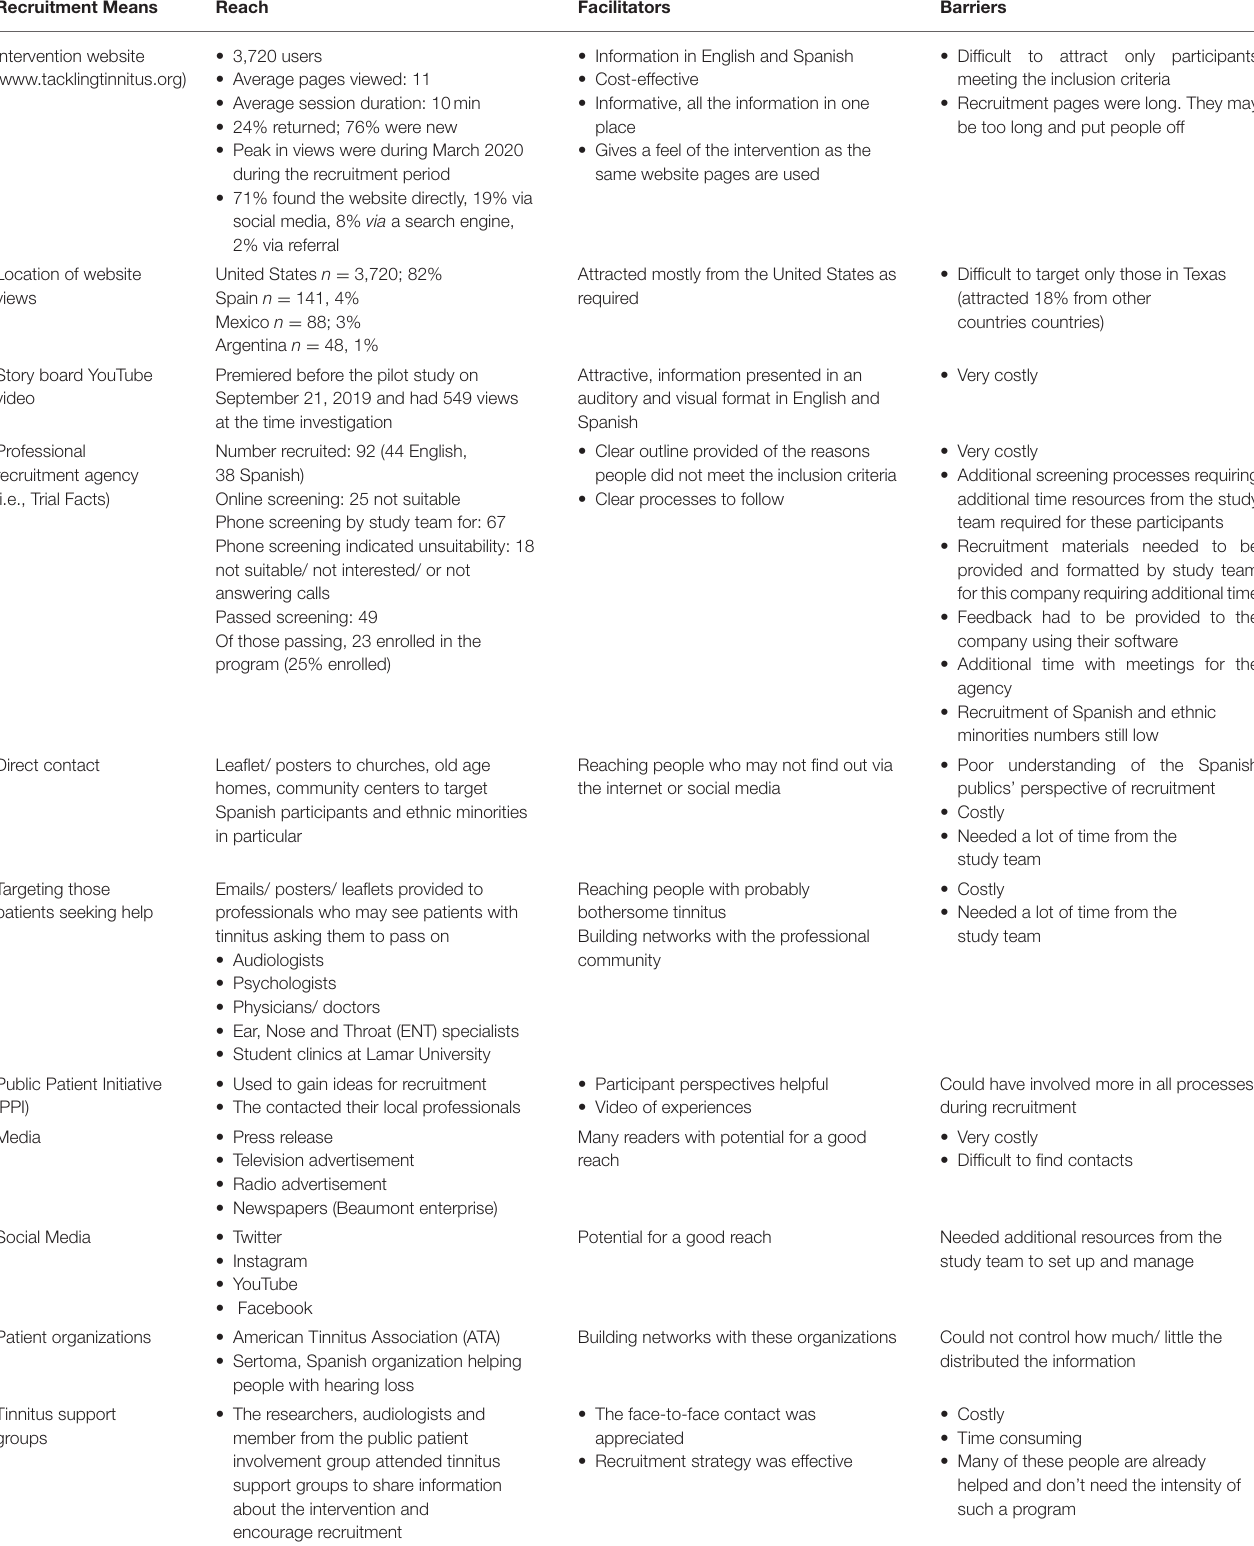
TABLE 2 | The various recruitment strategies used. Recruitment Means Reach